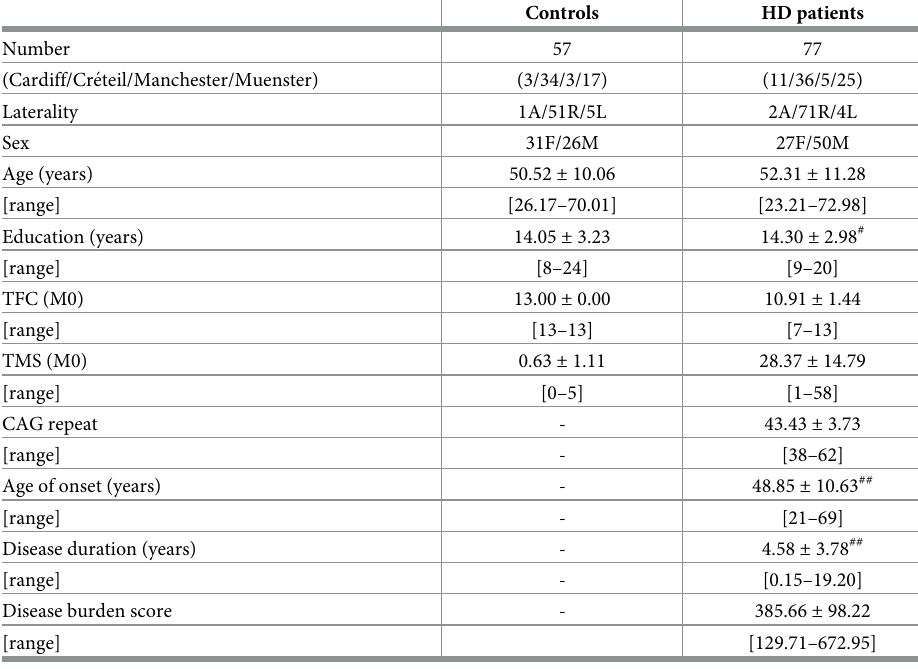
Table 1. Participant demographics at baseline